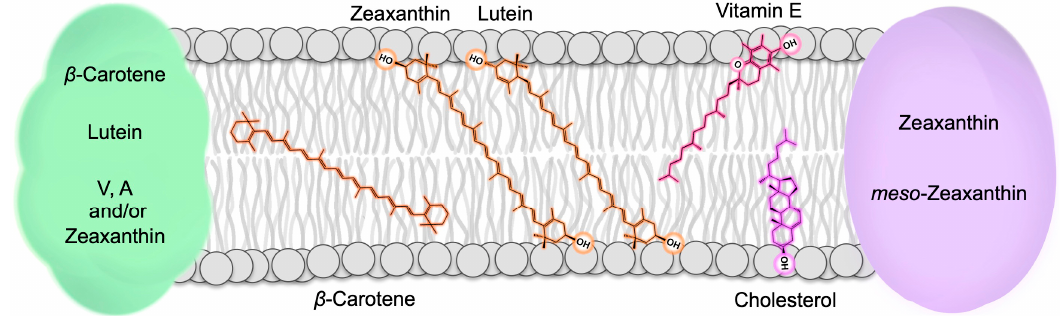
Figure 2. Schematic depiction of the localization of carotenoids, vitamin E (tocopherol), and cholesterol in biological membranes. Moreover, β -carotene, zeaxanthin, lutein, and tocopherols dissolve in the phospholipid biolayer of the membranes of both plants and humans / animals; cholesterol only occurs in animal membranes. In addition, binding of carotenoids to multiple components of light-collecting, chlorophyll-binding proteins in the photosynthetic membrane of plants (green oval) and of zeaxanthin and meso -zeaxanthin to a protein in the retinal membrane of humans (purple oval) is shown. A, antheraxanthin; V,